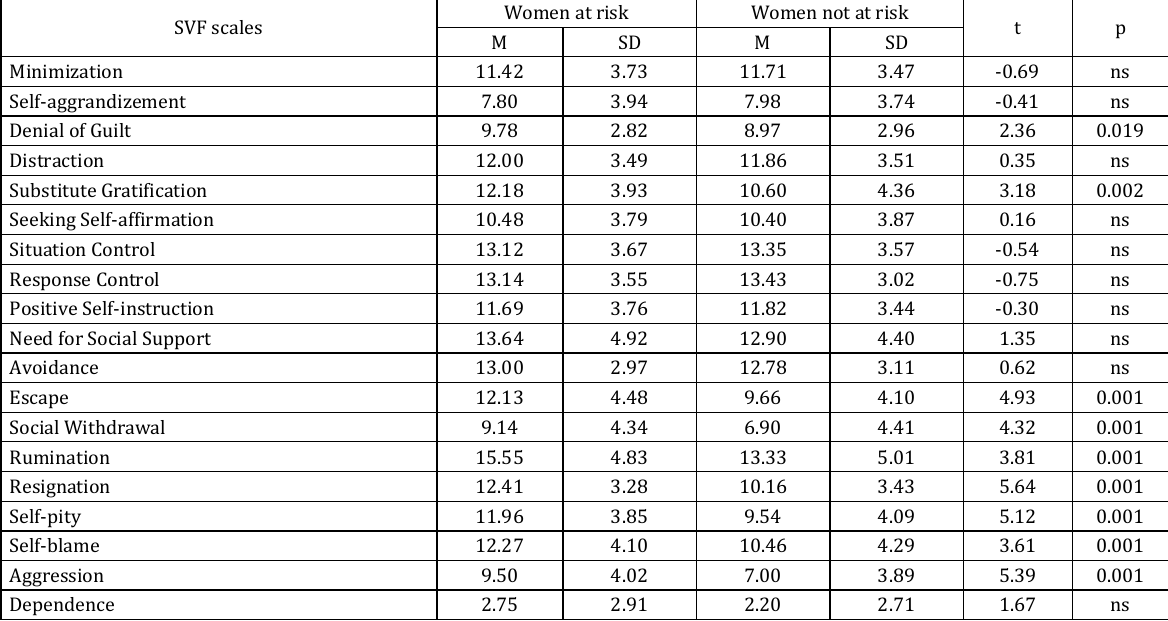
Table 2. A comparison of coping strategies in women at risk and not at risk of mobile phone addiction Women at risk Women not at risk SVF scales